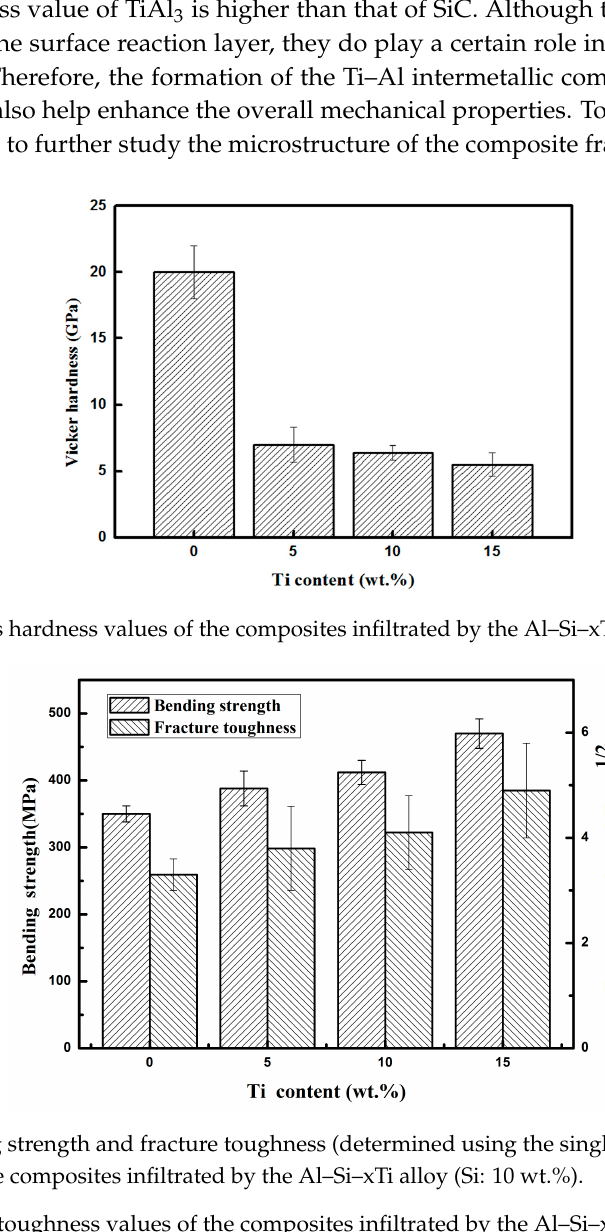
Table 3. EDS analysis results of different inner regions shown in Figure 3.